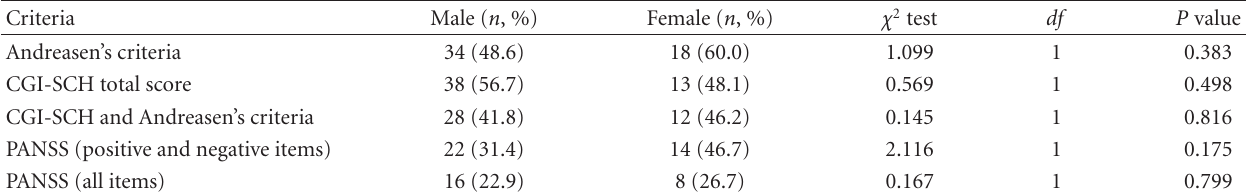
Table 4: Clinical remission rates according to